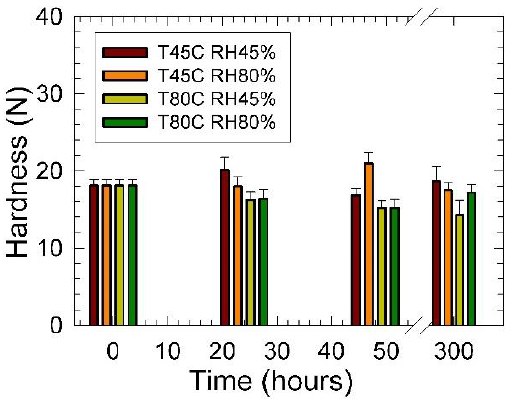
Figure 5. Hardness vs. conditioning time dependencies of studied PU foams at different temperatures and relative humidity. Inset: T — temperature (°C), RH — relative humidity (%).